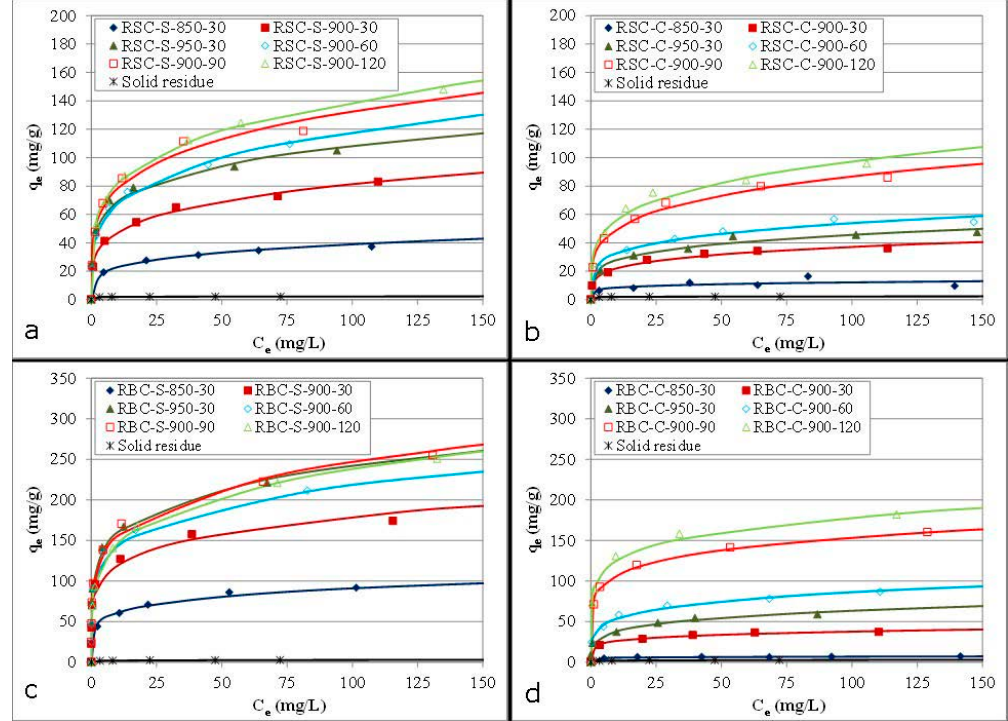
Figure 6. Phenol adsorption isotherms (dots: experimental data; lines: fit of the Freundlich model) of HCl-washed ACs produced from RSC by steam ( a ) and CO 2 ( b ) activation and of ACs originating from RBC activated by steam ( c ) and CO 2 ( d ).